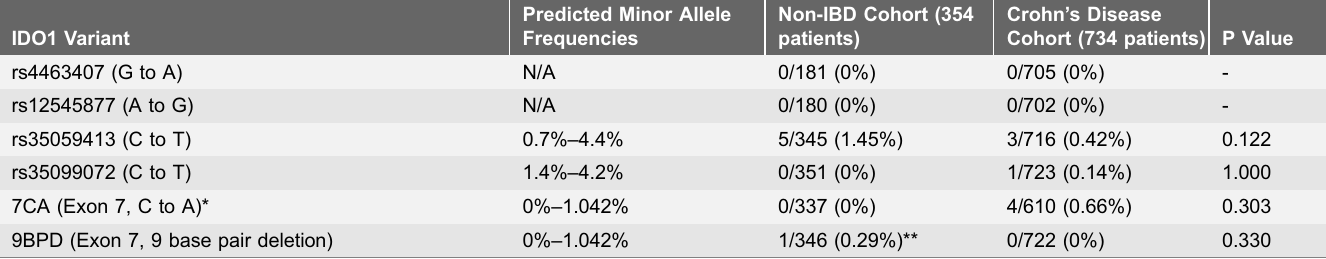
Table 1. Expected and identified frequency of patients with IDO1 Variant Alleles.